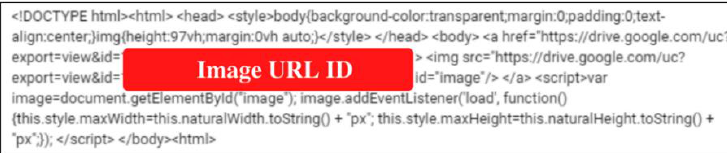
Figure 7. Dynamic image HTML embedded code.